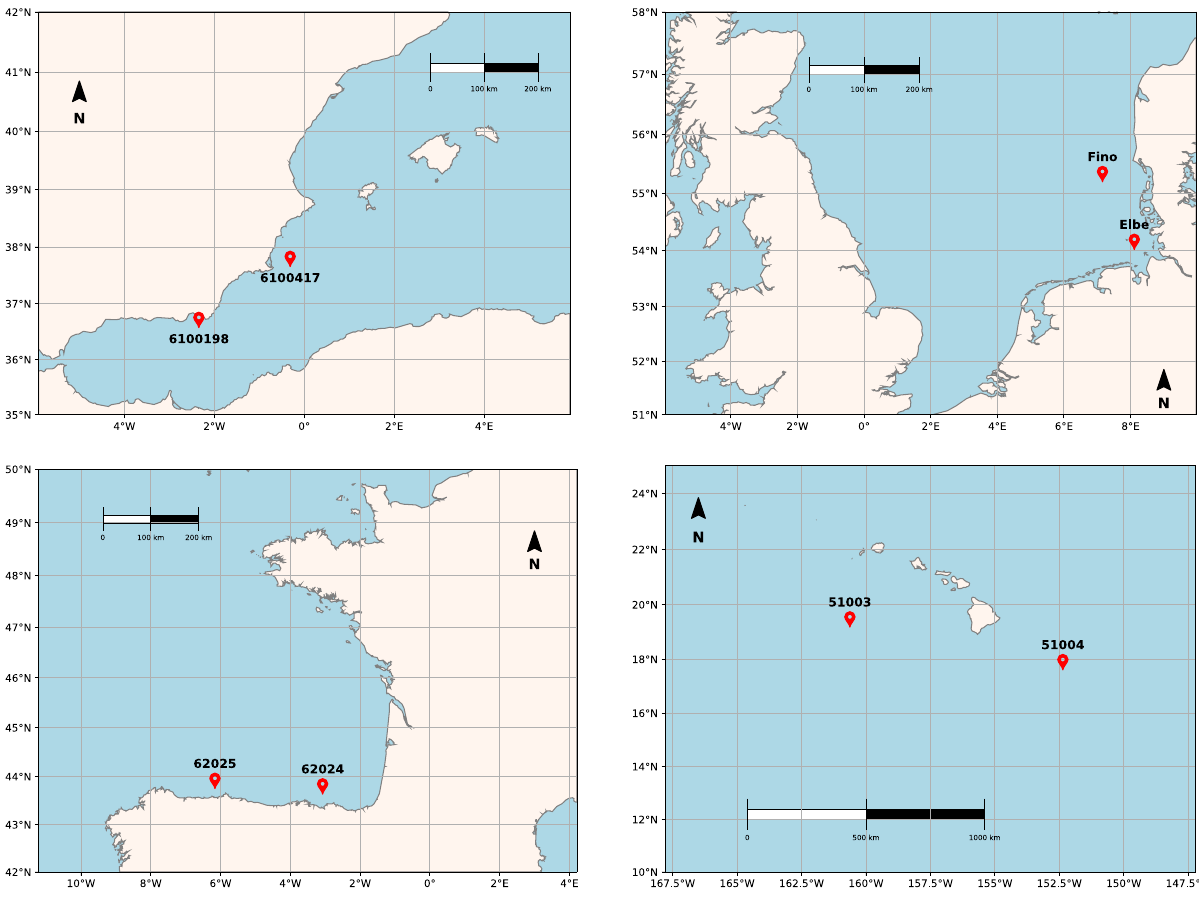
Figure 1. Maps. Locations of the pairs of buoys investigated. ( topleft ) The Gibraltar (Mediterranean Spain) case: buoys “6100417” and “6100198”. (top right) The North Sea case: buoys “Elbe” and “Fino”. (bottom left) The Bay of Biscay (Atlantic Spain) case: buoys “62024” and “62025”. (bottom right) The Hawaii (USA) case: buoys “51003” and